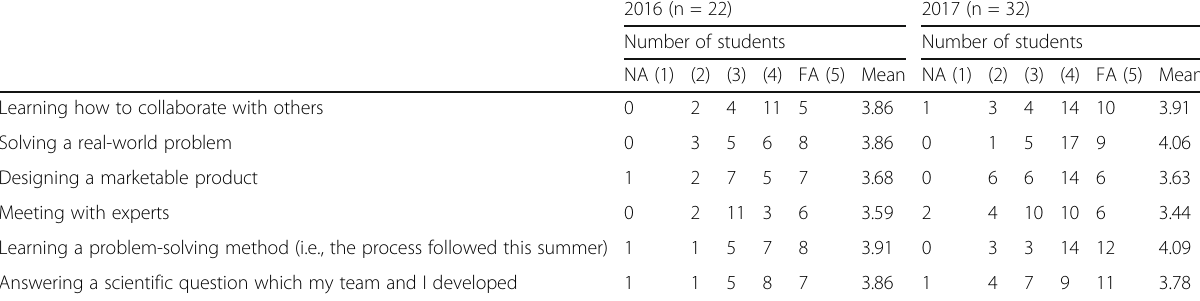
Table 4 Summer 2016 and 2017 electronic survey results — component coverage. Prompt 2: Rate the degree to which the following components were addressed in